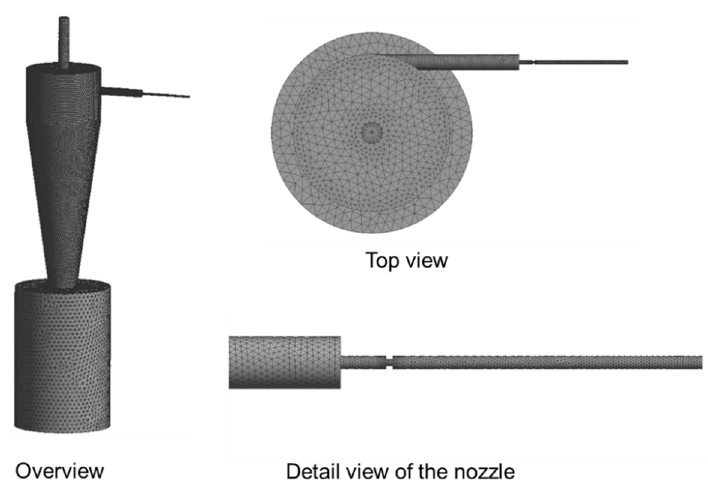
Figure 6. Computational grids and cells for the numerical calculations (total of 391,720 cells).